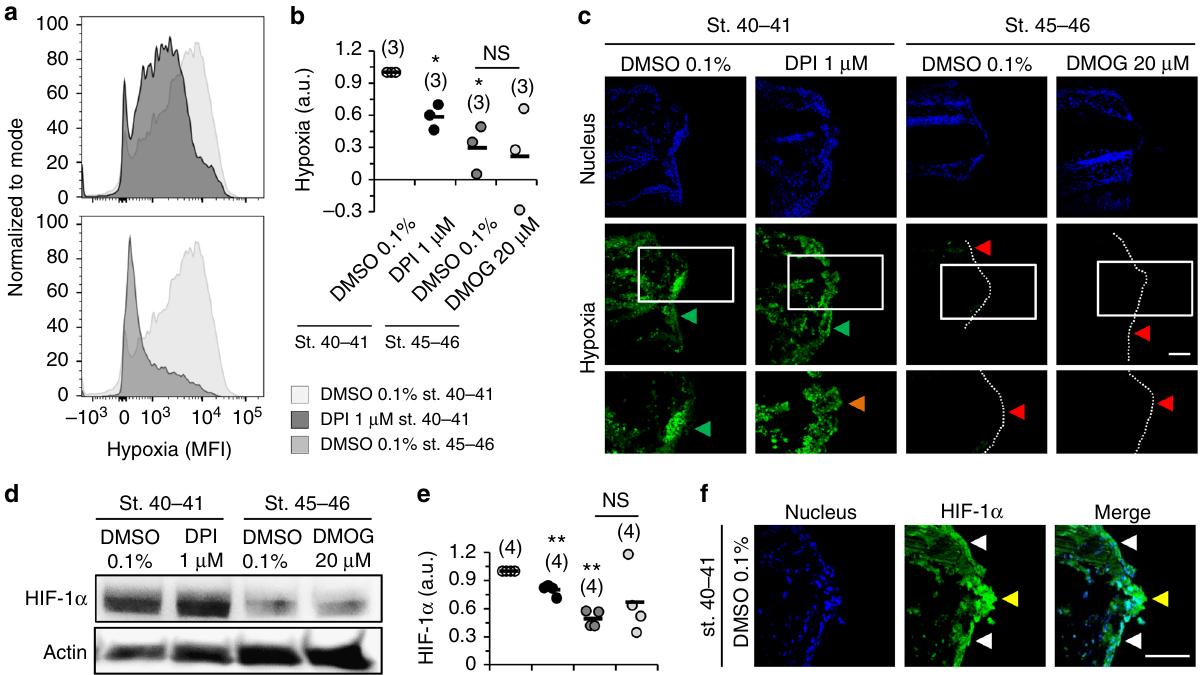
Fig. 5 Hypoxia and HIF-1 α stabilization correlate with regeneration ef fi ciency. a – c Hypoxia is signi fi cantly affected by depleted ROS and dramatically affected in refractory period. a Representative fl ow cytograms of DMSO 0.1% st. 40 – 41 vs. DPI 1 μ M st. 40 – 41 (top panel) and DMSO 0.1% st. 40 – 41 vs. DMSO 0.1% st. 45 – 46 (bottom panel) at 1 hpa. MFI mean fl uorescence intensity. b Semi-quantitative analysis of hypoxia penetrance normalized to the vehicle-control. Horizontal axis labels in b also apply to e . c Hypoxia immuno fl uorescence imaging in vehicle-control and pharmacological treatment from tadpoles amputated in regenerative (st. 40 – 41) and refractory (st. 45 – 46) periods at 1 hpa. Independent experiments gave consistent readouts. Bottom panels: high magni fi cation of correspondent rectangles in middle panels. Green arrowhead: high hypoxia in the wound epithelium (middle panels) and prospective regeneration bud (bottom panels); orange arrowhead: low hypoxia in the prospective regeneration bud (bottom panels); red arrowhead: no hypoxia in the wound epithelium (middle panels) and prospective regeneration bud (bottom panels); white dotted line: posterior tail outline. d – f HIF-1 α stability levels are signi fi cantly affected by depleted ROS and dramatically affected in refractory period. d Representative western blot in all conditions at 1 hpa. e Semi-quantitative analysis of HIF-1 α stability levels normalized to the vehicle-control. f HIF-1 α immuno fl uorescence imaging in the regenerative condition at 1 hpa. Independent experiments gave consistent readouts. Yellow arrowhead: high HIF-1 α stability in the prospective regeneration bud; white arrowhead: high HIF-1 α stability in the wound epithelium. a.u. arbitrary units; scale bars: 100 μ m. Statistical analyses were performed by paired Student ’ s t - test (two-tailed p -value). n fl ows of 20 specimens each, or n blots of 30 specimens each indicated in brackets. NS non-signi fi cant; * p < 0.05; ** p <